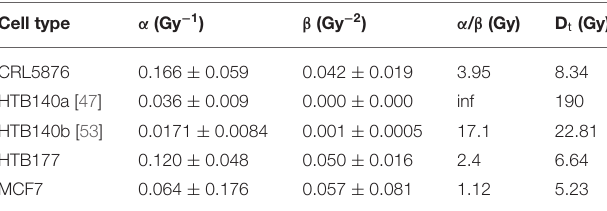
TABLE 1 | Photon input parameters for the LEM calculations shown in Figure 2